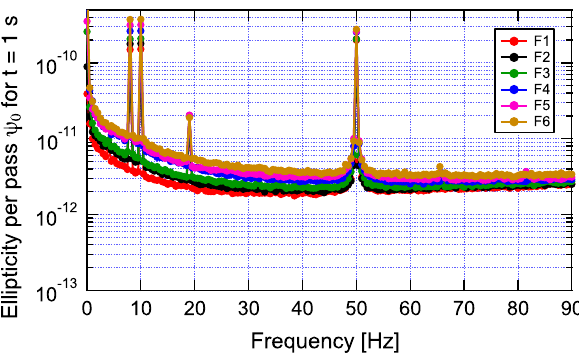
Fig. 12 The six ellipticity spectra of Fig. 10 rescaled assuming a rota- tion noise S (cid:13) proportional to N and taking into account the frequency